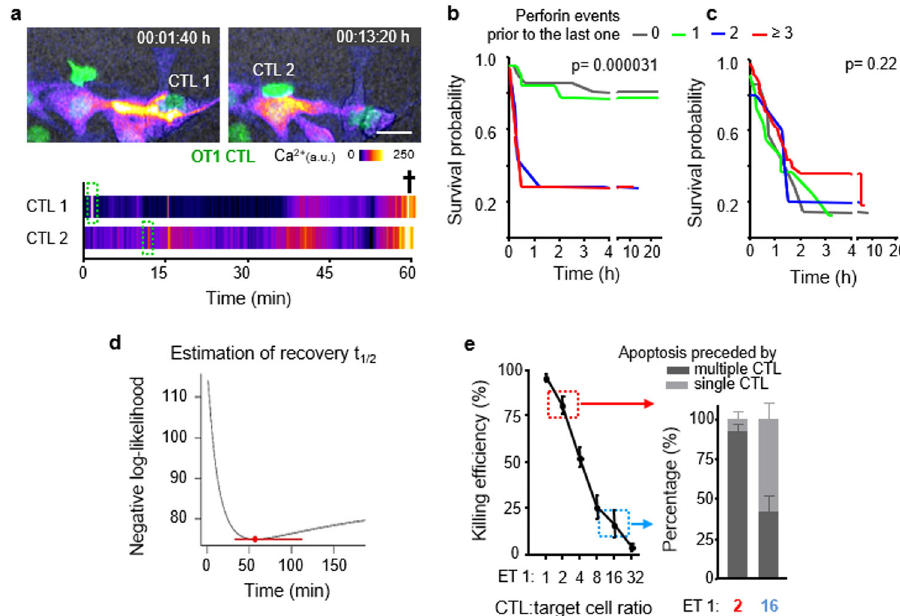
Fig. 5 Additive cytotoxicity and estimation of damage recovery half-life. a Time-lapse sequence and intensity plot of multiple Ca 2 + events followed by target cell apoptosis. Green fl uorescence, OT1 CTL (dsRed); Fire LUT, Ca 2 + intensity (GCaMP6s). Cross, target cell death; Scale bar, 20 µ m. Image sequence shows a representative example from 124 perforin events preceding N = 63 B16F10/OVA apoptosis events, pooled from 5